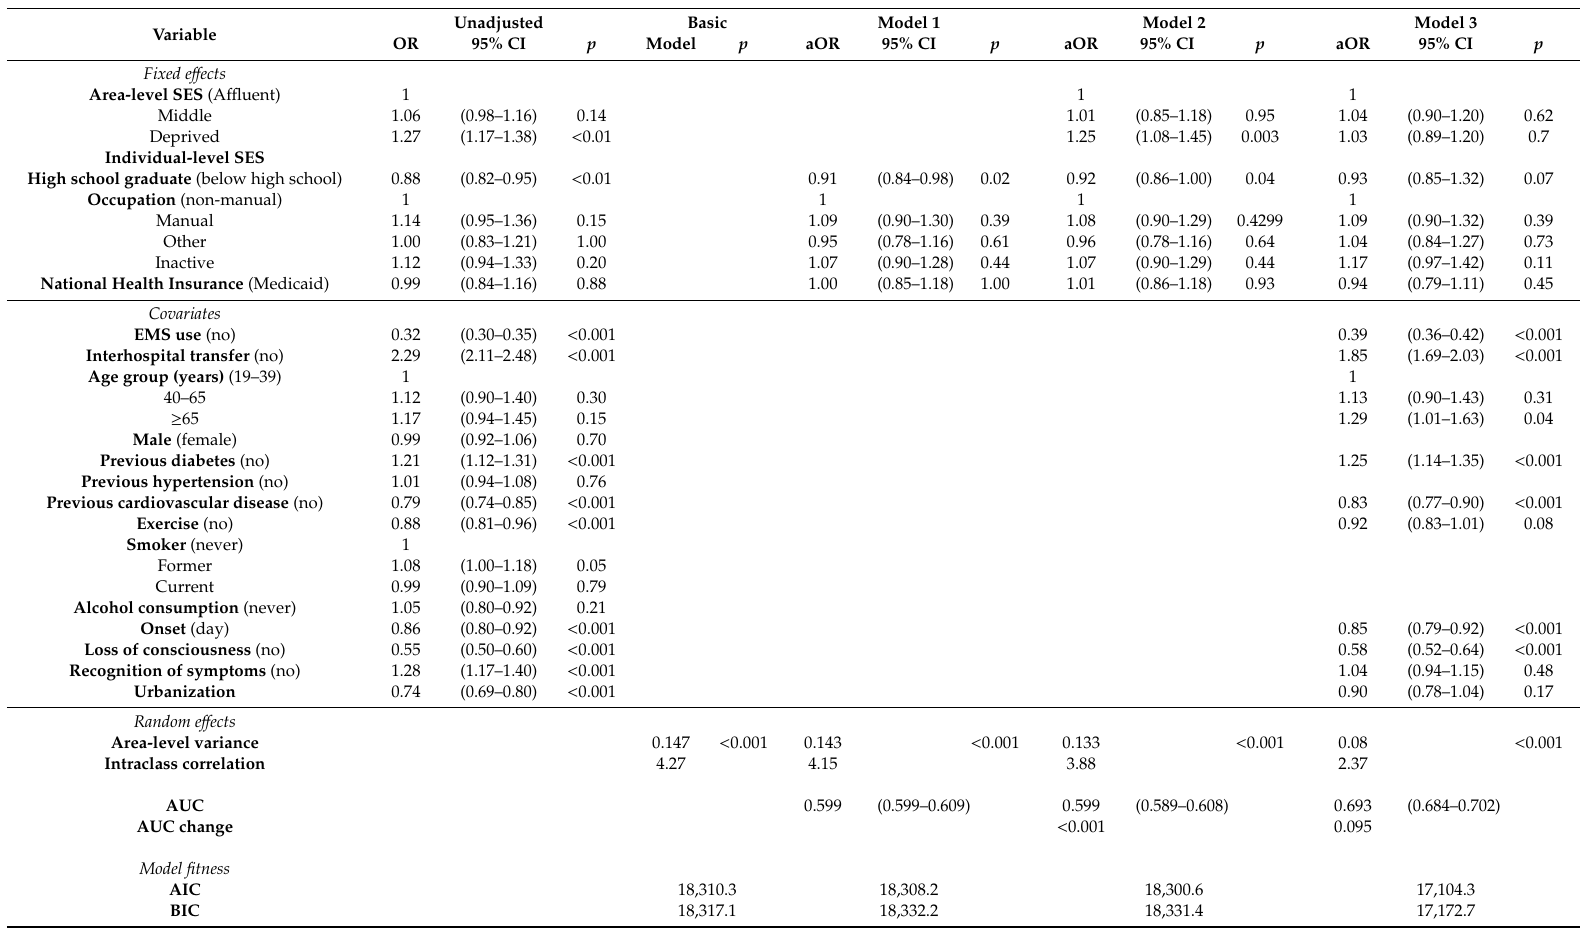
Table 3. Multilevel multivariable logistic regression analysis for prehospital